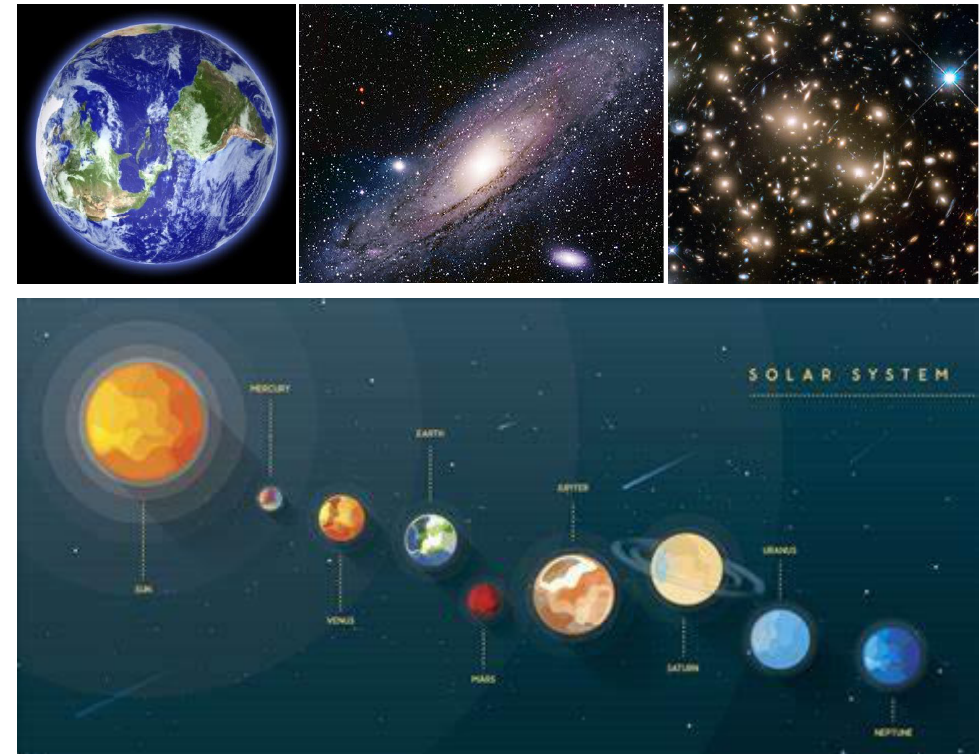
Figure 3. In order to avoid any possible misunderstanding about the legitimacy of the pencil shown in Figure 2 to serve as an external frame of reference, we present here a perspective of the cosmological scenario in which all measurements are performed: neither the orange band nor the pencil can be preferred over the other as a legitimate external frame of